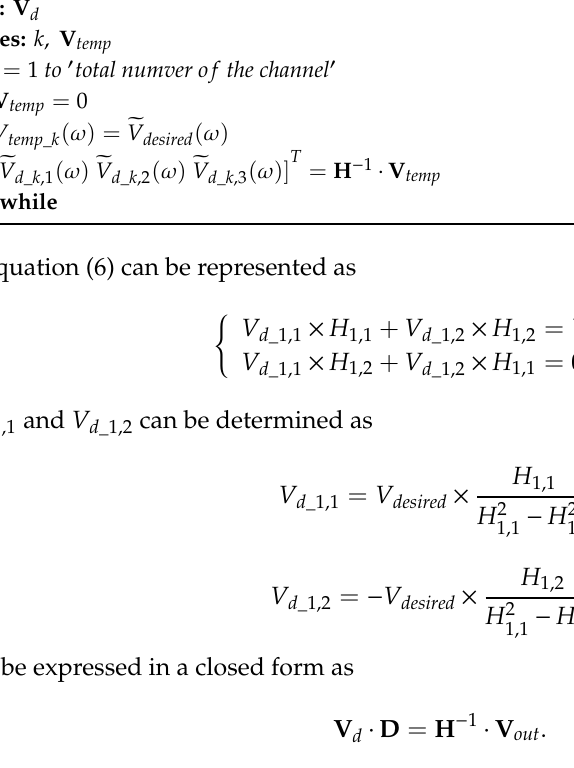
Figure 3. Block diagram of signal flow within the symmetric two-coupled line system. Algorithm 2: Equalizer for Multi-Lines